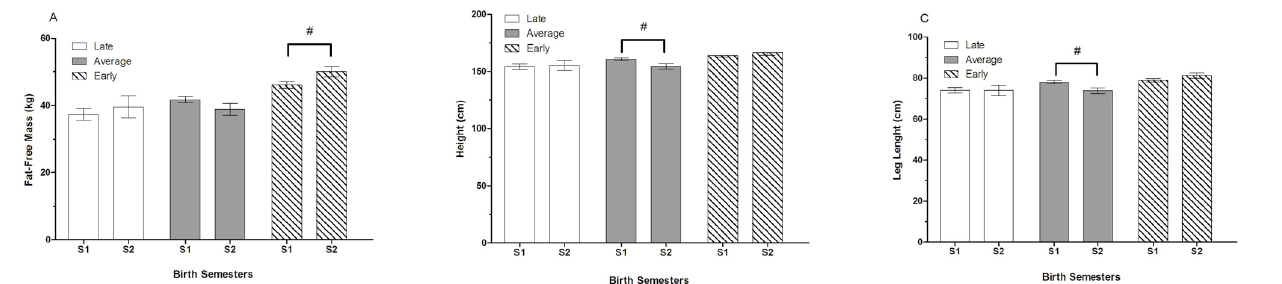
Figure 2. Age-adjusted mean ± standard error for fat-free mass (panel A), height (panel B) and leg length (panel C) within each skeletal maturity status by birth semesters in young soccer